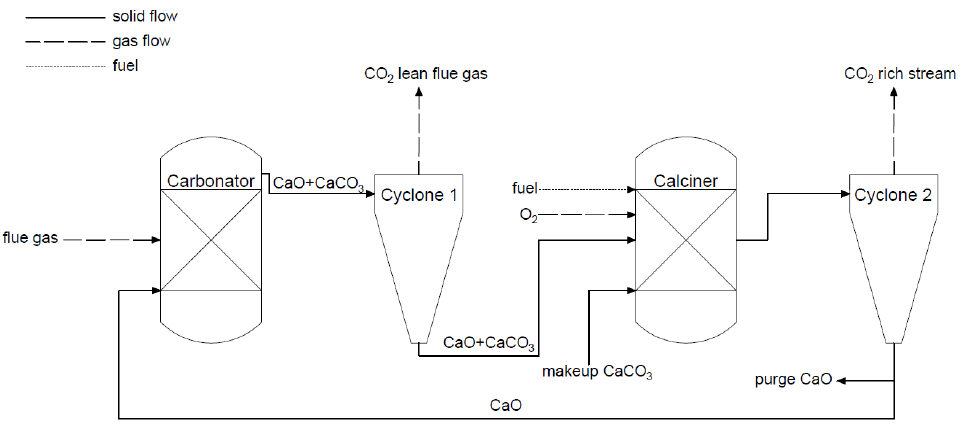
Figure 8. Scheme of the calcium looping process (adapted from [37]).